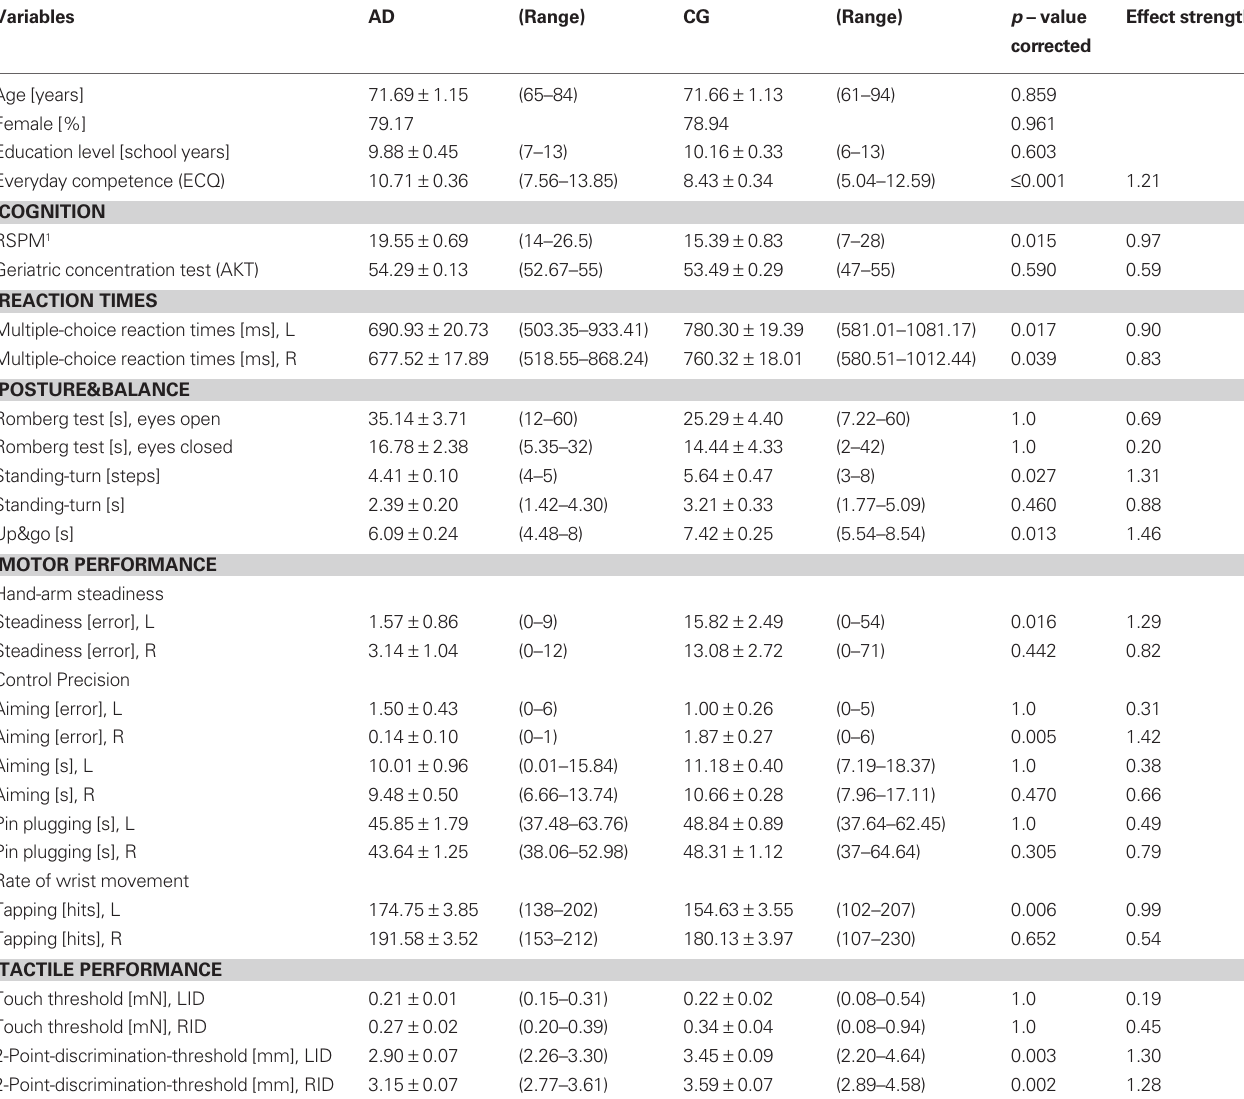
Table 1 | Comparison of cognitive, posture, balance and sensorimotor status of AD and CG.